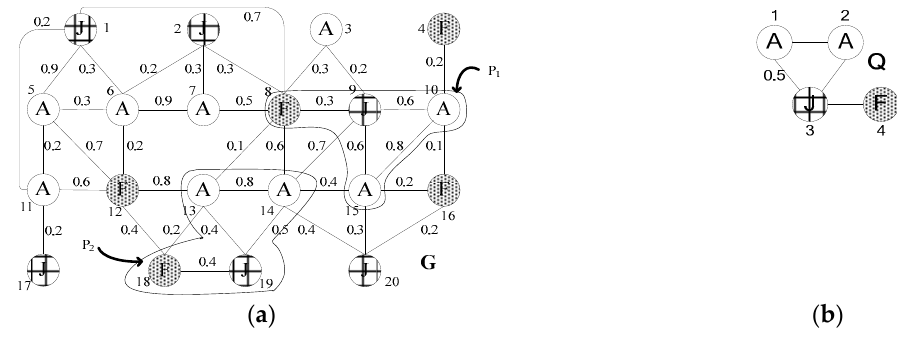
Figure 2. Matching subgraph P 1 and P 2 of Q. ( a ) data graph G; ( b ) query graph Q.